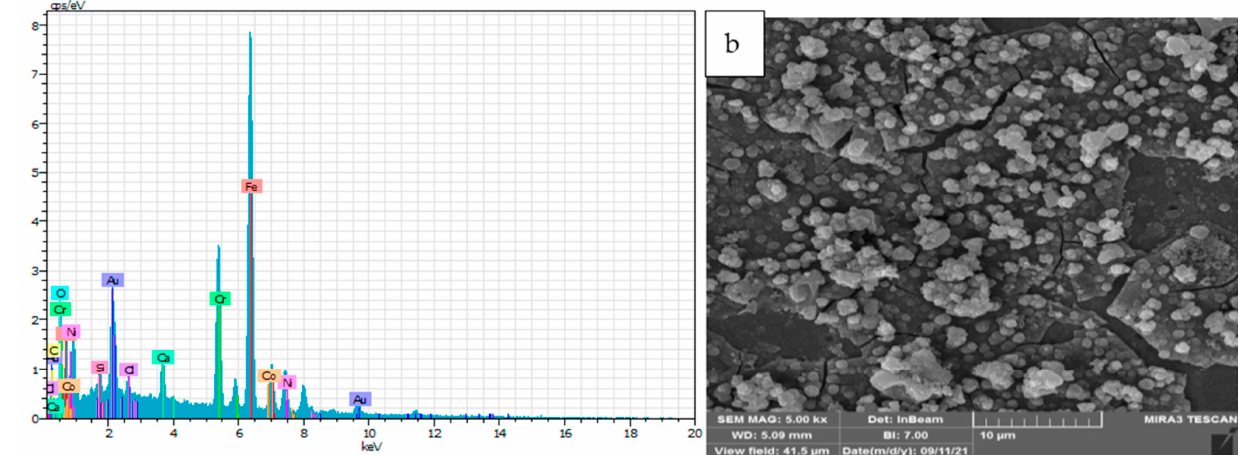
Figure 12. SEM images of iron surface before ( a ) and after EC ( b ).